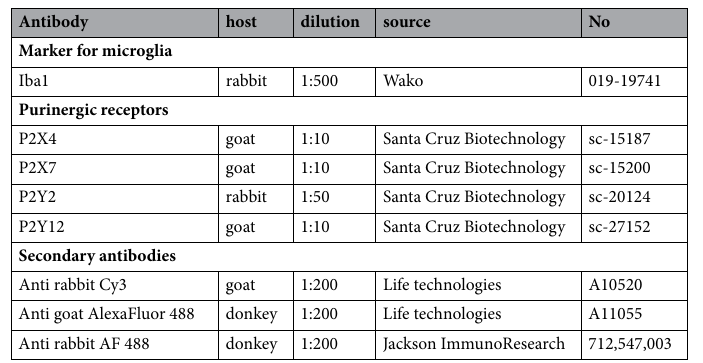
Table 2. Primary and secondary antibodies used in this study.